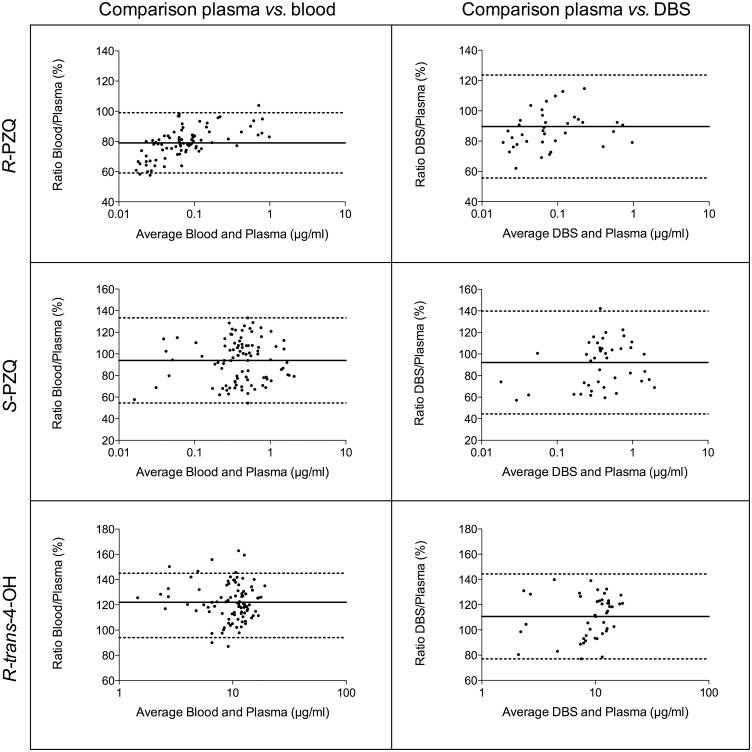
Bland-Altman plots of measurement performed with blood or DBS compared to plasma values for R-PZQ, S-PZQ and R-trans-4-OH with mean ratio sketched with a solid line and 95% limits of agreement with dashed lines.